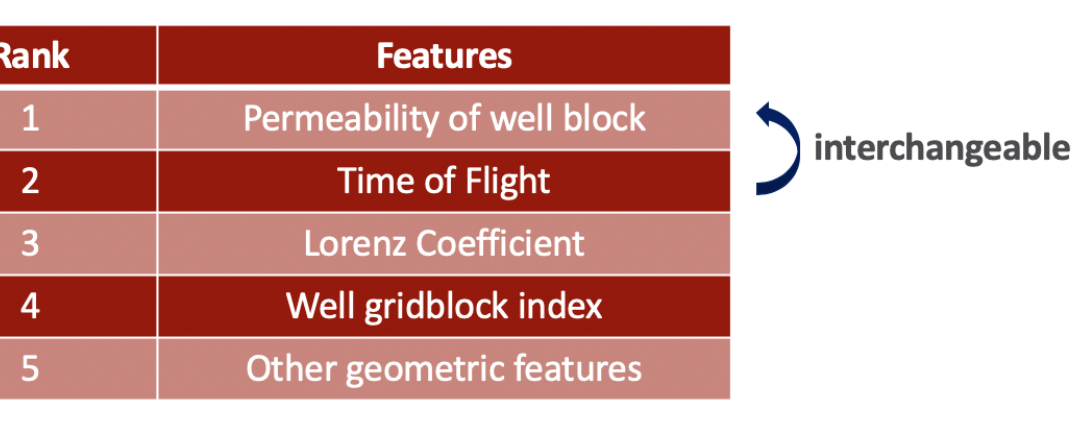
Figure 48. Feature Rank as calculated by the Random Forest